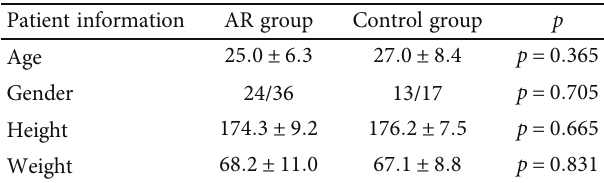
Table 1: Comparison of patient information between the AR group and control group ( x ± s